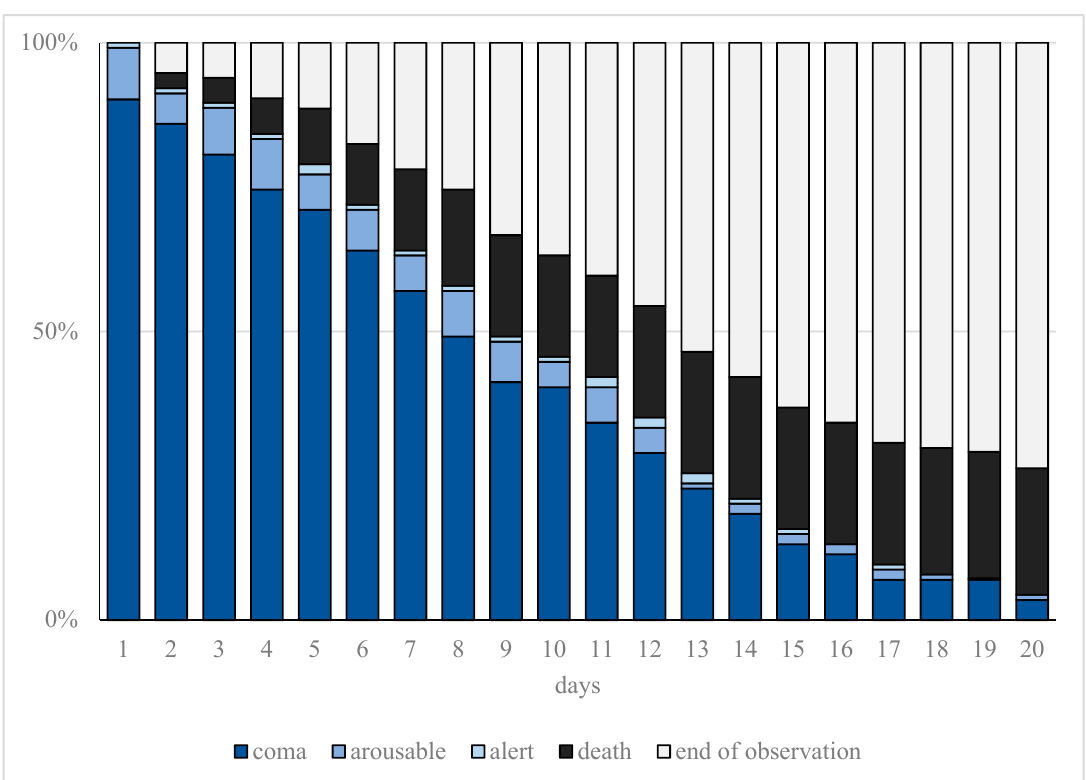
Table 2. Linear regression for sedative dosages and CARDS associated conditions as well as preconditions.